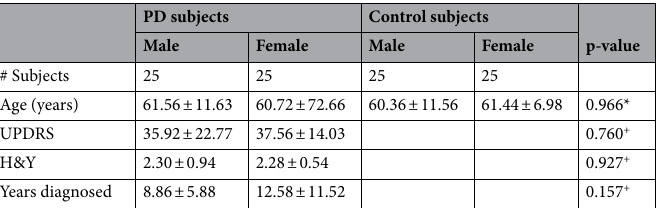
Table 1. Participants’ demographics of PC-GITA database. *Calculated using ANOVA with 95% confidence level. + Calculated using unpaired T-test with 95% confidence level.